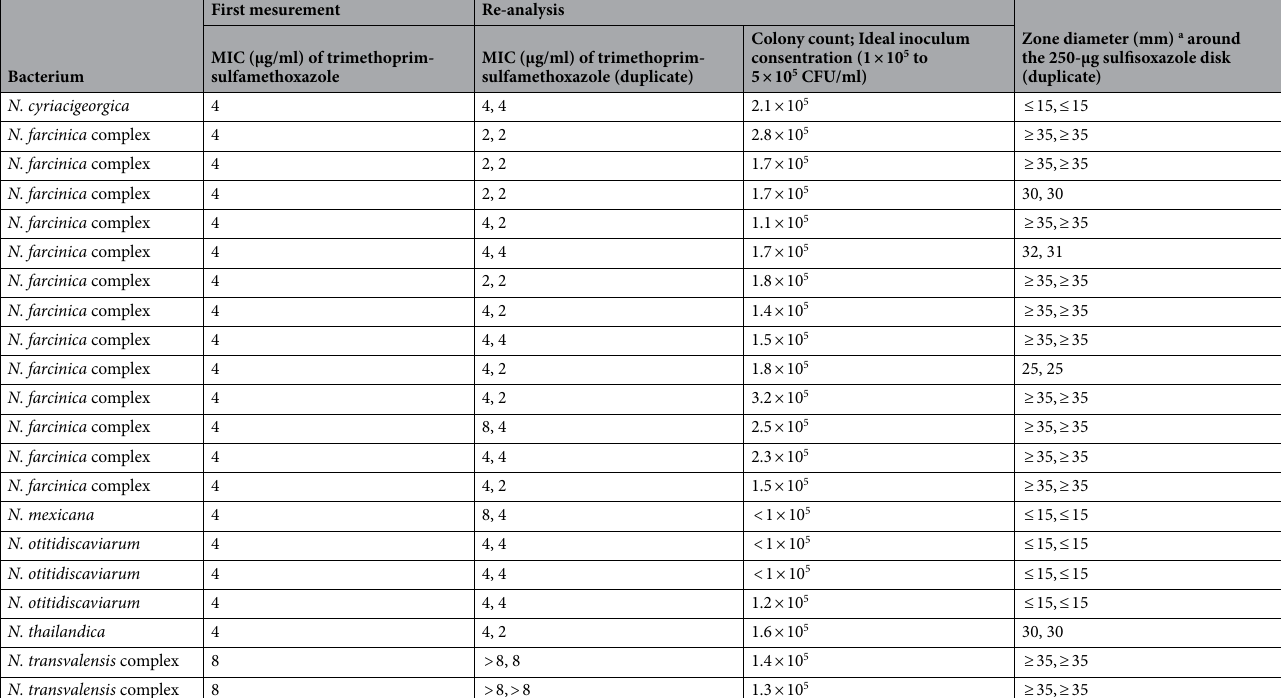
Table 4. Results of disk diffusion testing with a 250-μg sulfisoxazole disk and re-analysis of broth microdilution method against 21 TMP-SMX-resistant isolates. a A zone ≥ 35 mm indicates susceptibility, zones between 16 and 34 mm are not interpretable, and a zone ≤ 15 mm indicates